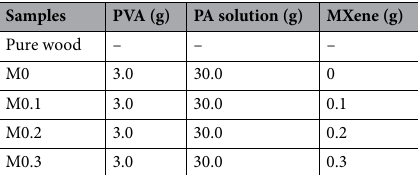
Table 1. The composition of different